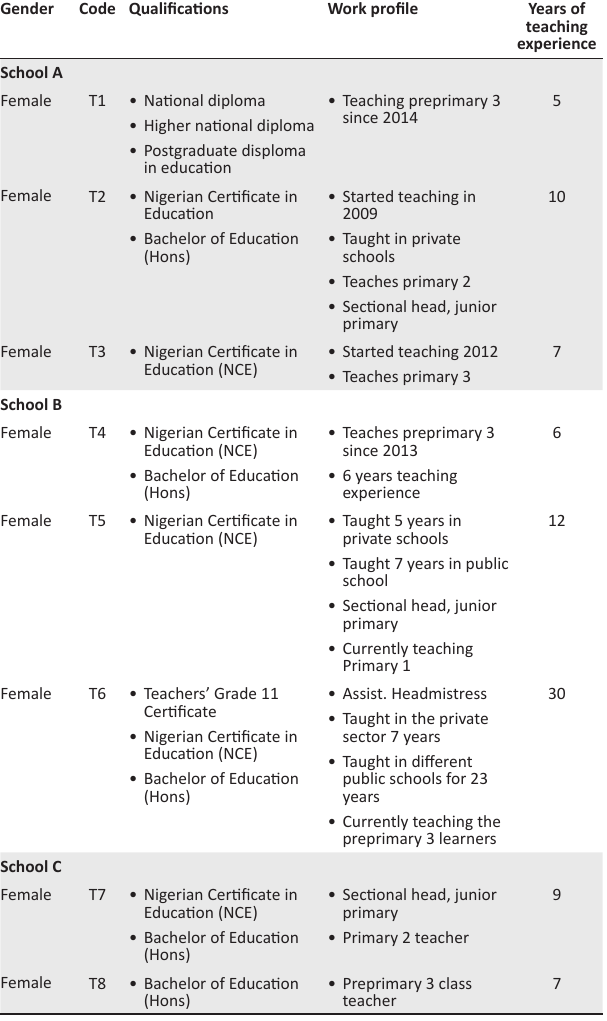
TABLE 1: Profiling of teacher participants’ gender, codes, work profiles, schools and teaching experience. Gender Code